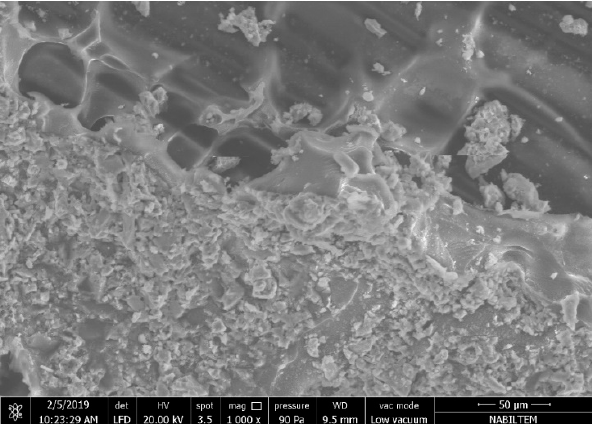
Figure 17. Fabric–matrix interface in the composite produced with M120 mortar.